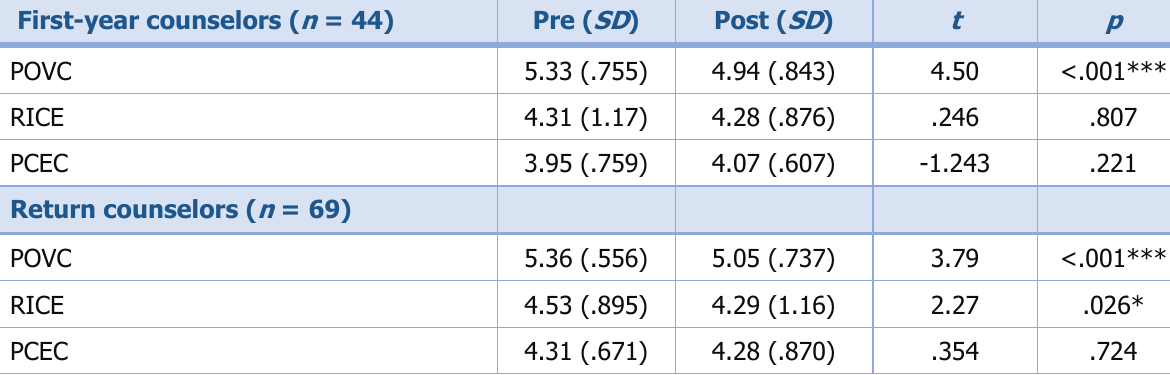
Table 2: Changes in Creativity Expectations Across Camp Season by Counselor Type First-year counselors (n = 44)